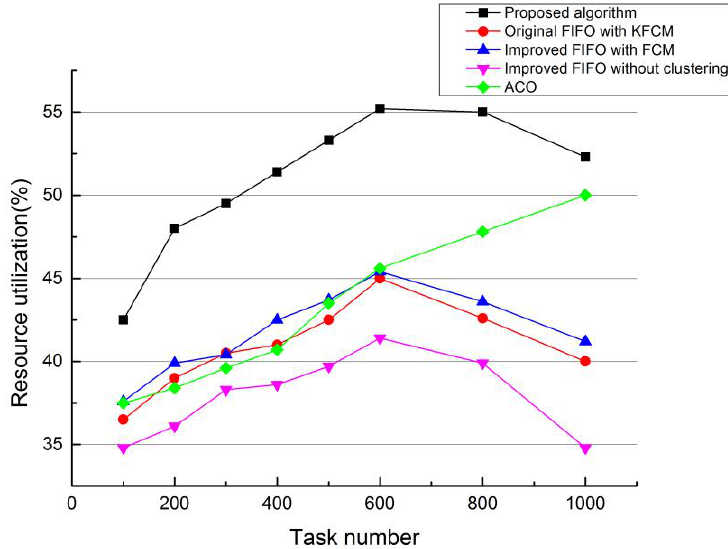
Figure 6. Resource utilization of the four algorithms.